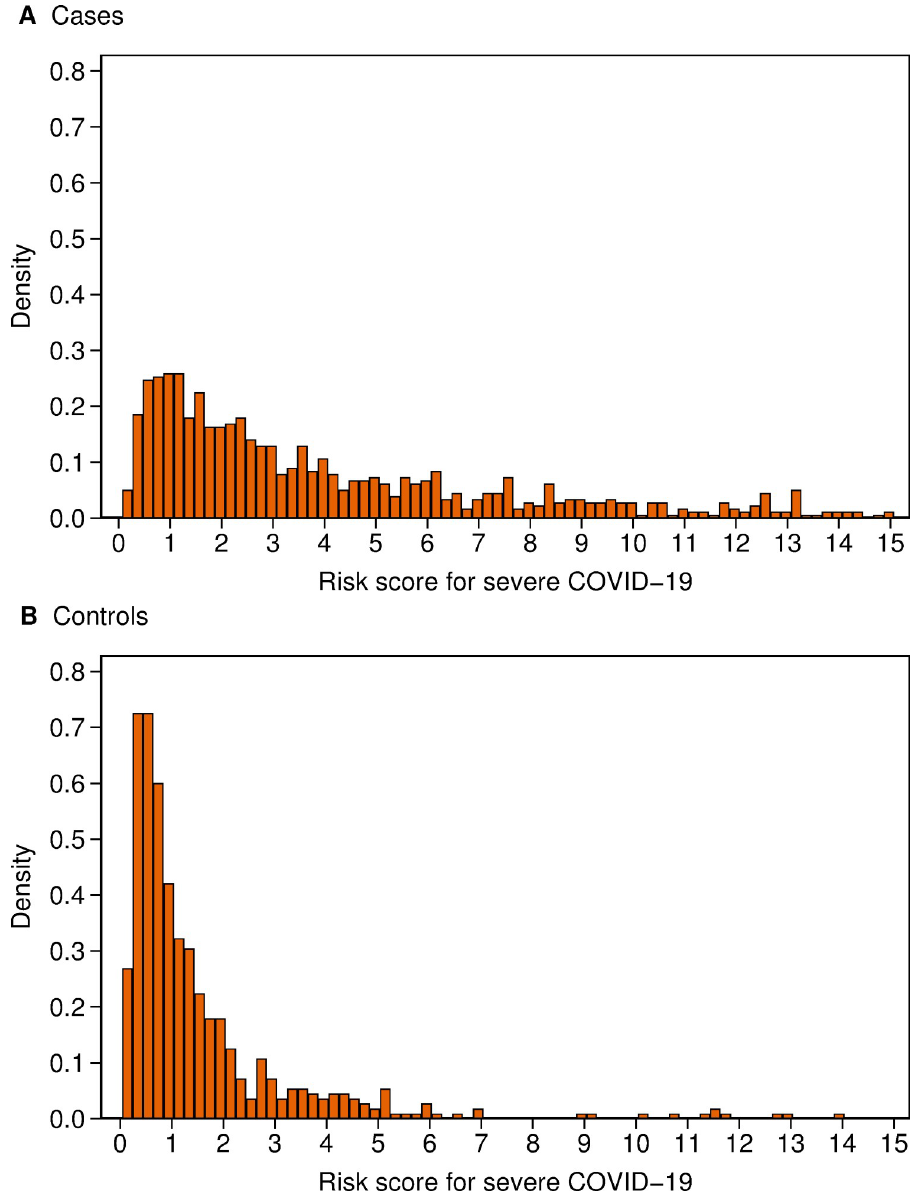
Fig 2. Distribution of risk score for severe COVID-19 risk score for (A) cases and (B) controls. Note that 130 (13%) cases and 6 (1%) controls with scores of 15 or over have been omitted to facilitate the display of the distribution. Fig 2 illustrates the difference in the distributions of the COVID-19 risk scores in cases and controls. The median score was 3.35 for cases and 0.90 for controls, with inter-quartile ranges of 6.70 and 1.34, respectively. Sixteen per cent of cases and 53% of controls had COVID-19 risk scores of less than 1, and 18% of cases and 25% of controls had scores � 1 and < 2. COVID-19 risk scores � 2 were more common in cases than in controls, with 13% of cases and 9% of controls having scores � 2 and < 3, 8% of cases and 4% of controls having scores � 3 and < 4, and 45% of cases and 9% of controls having scores � 4.